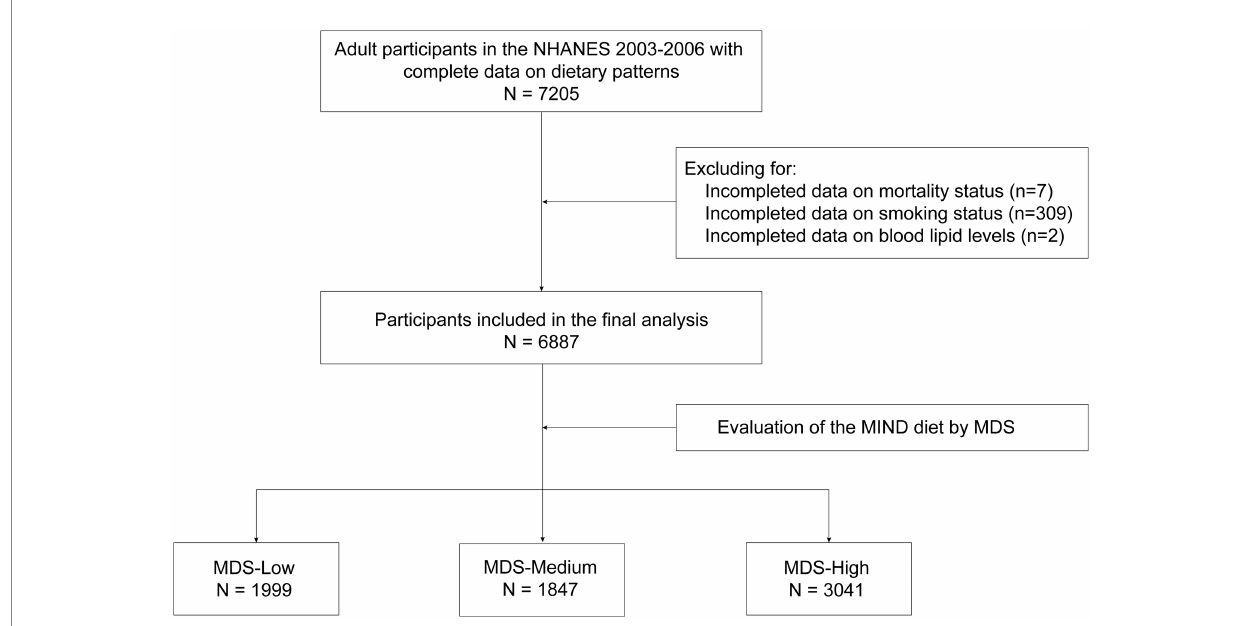
FIGURE 1 Flowchart of participant selection. MDS-Low, Low MIND score, the MIND diet score < 7.5; MDS-Mdeium, Medium MIND score, the MIND diet score ≥ 8 and < 8.5; MDS-High, High MIND score, the MIND diet score ≥ 8.5. NHANES, National Health and Nutrition Examination Survey; MIND diet, Mediterranean-DASH Diet Intervention for Neurodegenerative Delay diet; MDS, the MIND diet